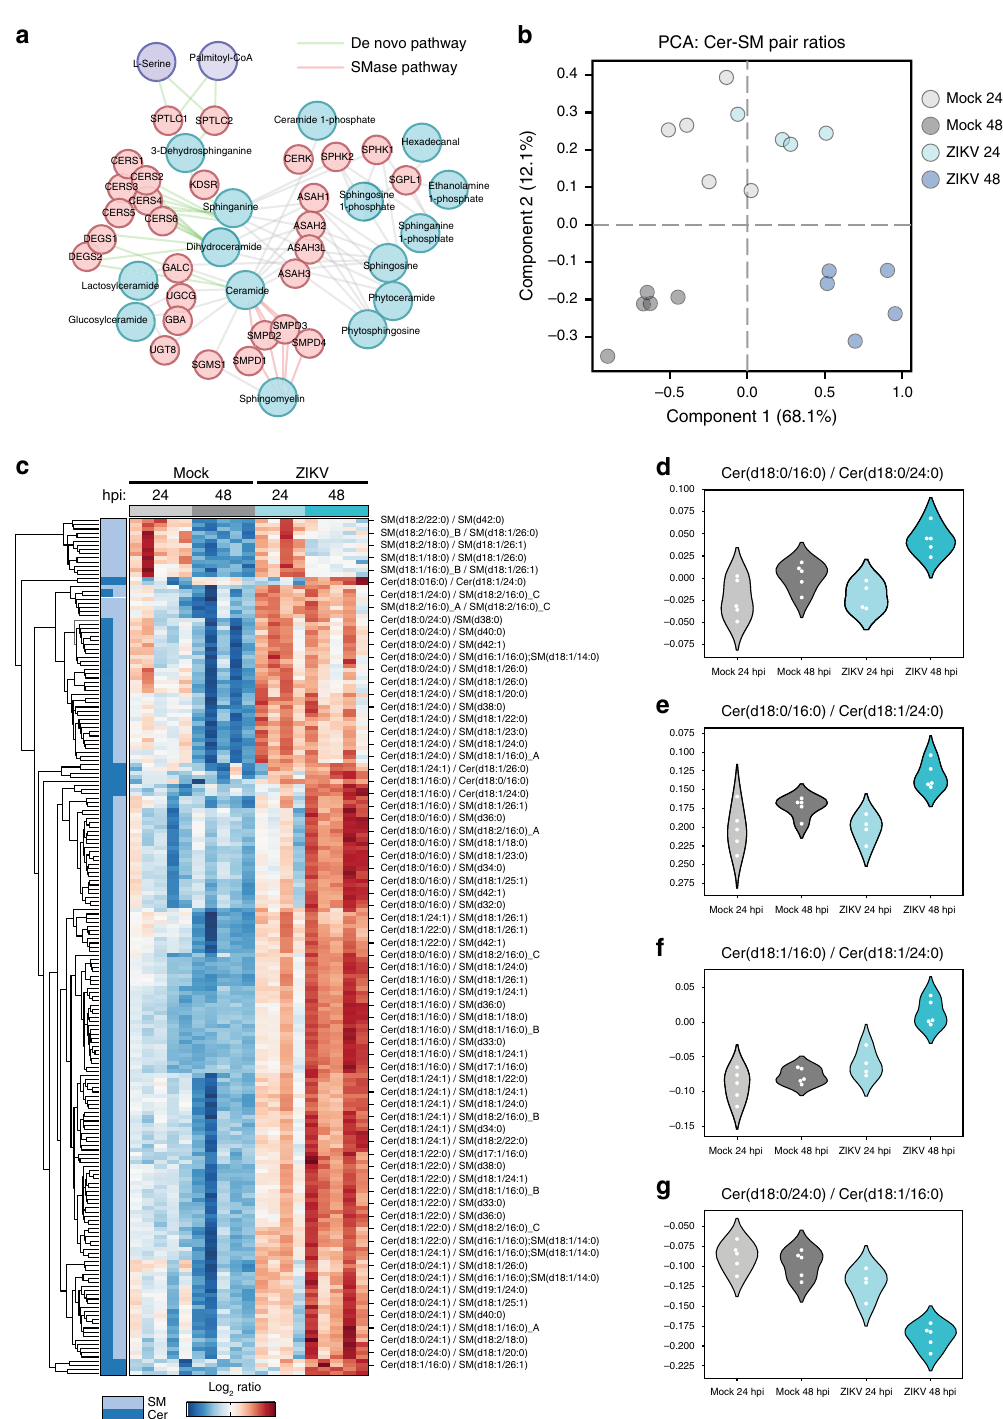
Fig. 5 Targeted regulation of sphingolipid metabolism by ZIKV. a Overview of the ceramide metabolism network. b Ratios of normalized lipid levels were calculated for all combinations of SM and Cer species in our dataset. Ratios that varied signi fi cantly across conditions ( n = 382, P < 0.01, one-way ANOVA) were analyzed with recursive feature elimination with cross-validation, and the resulting high-interest Cer/SM pairs ( n = 250) were analyzed with PCA. c Heatmap of clustered log2 SM/Cer ratios identi fi ed in ( b ). Each column represents a single biological sample. d – g Log2 ratios from ( b ) that met the following criteria: PC length > 0.1, F score > 50, and P < 0.01. SM sphingomyelin, Cer ceramide. See also Supplementary Data 4 and the Source Data fi